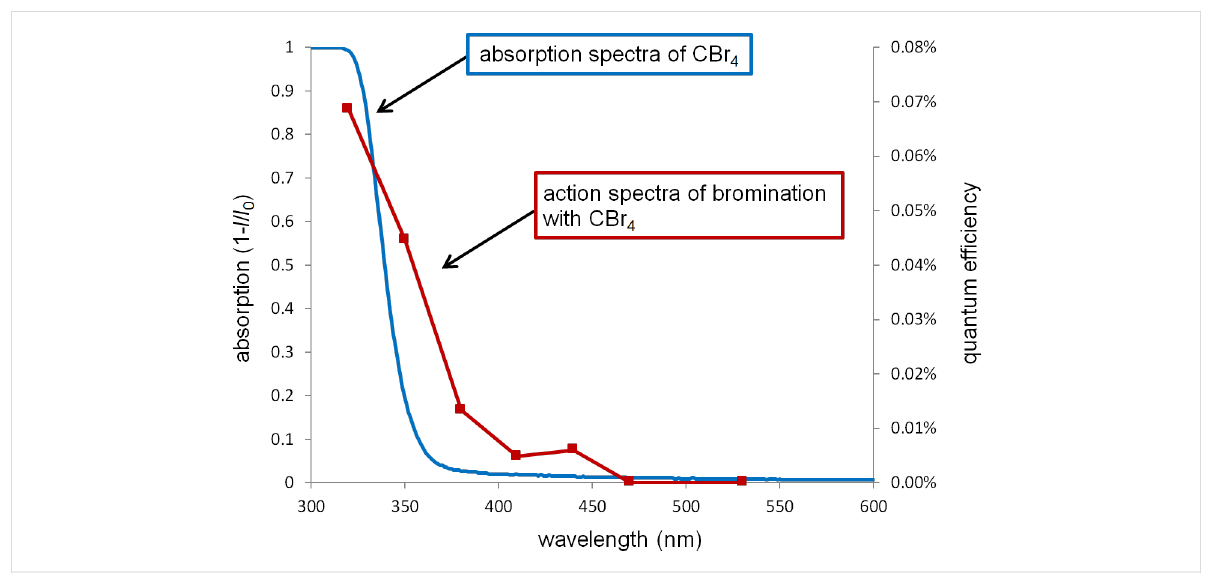
Figure 1: Action spectrum of bromination with CBr 4 , induced by LED irradiation (red line), and absorption spectrum of CBr 4 (blue line).